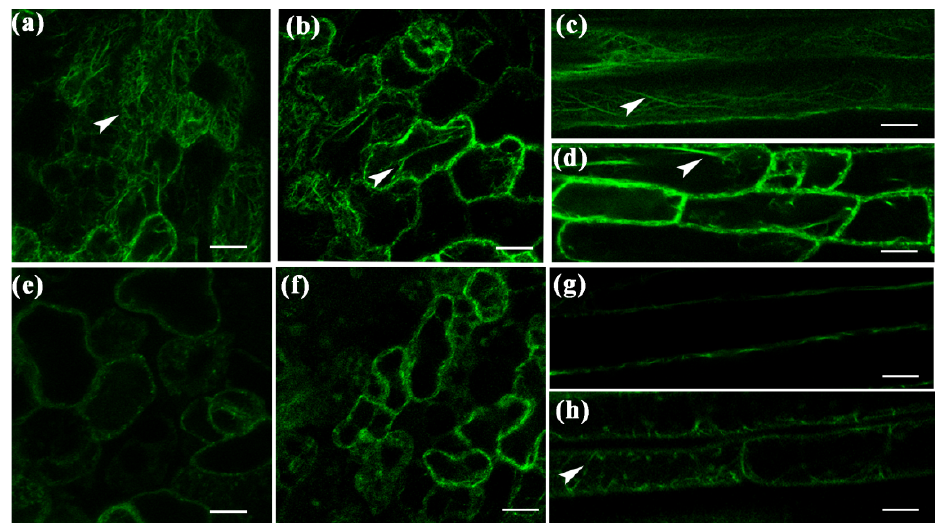
Figure 9. Effect of Ab-FAR-1 on actin cytoskeleton. The actin cytoskeleton (green) of leaf epidermis ( a,b ) and hypocotyl ( c,d ) in wild-type and Ab-FAR-1 transgenic wild-type Arabidopsis thaliana seedlings.. Latrunculin B-treated leaf epidermis ( e,f ) and hypocotyl cells ( g,h ) of wild-type and Ab-FAR-1 transgenic A. thaliana seedlings. The white arrow indicates the location of actin filaments. Bar = 10 μ m.